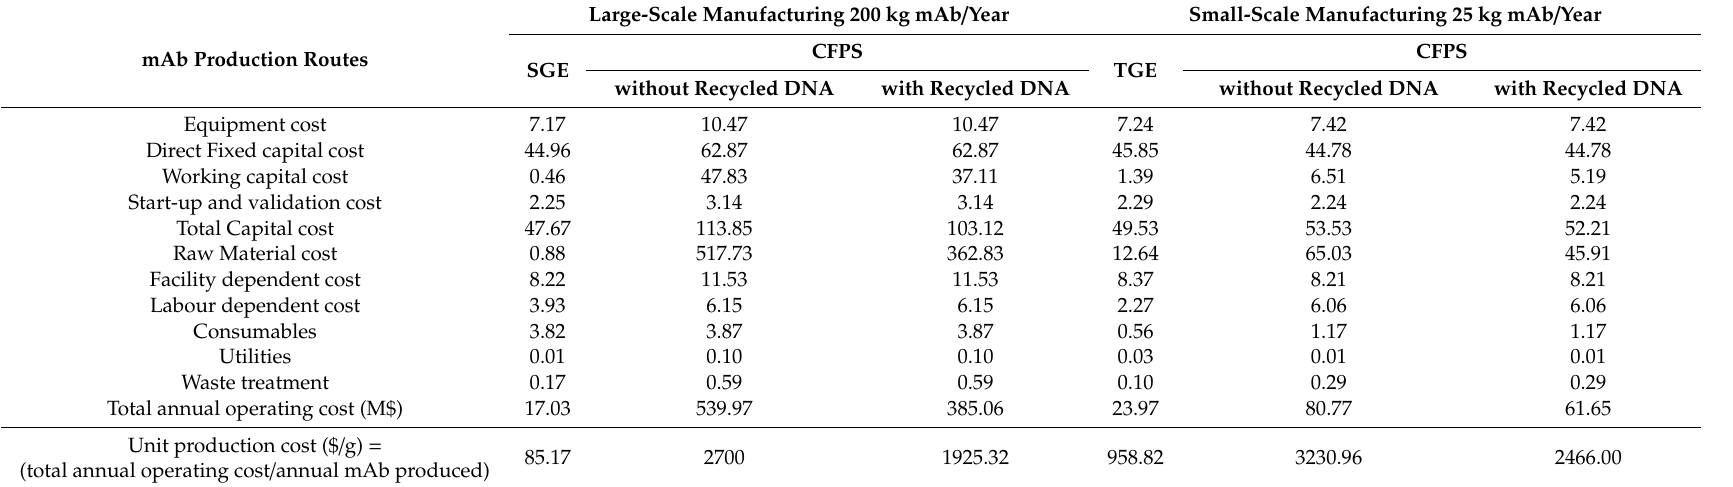
Table 1. Process economics for mAb production for large-scale (SGE, CFPS) and small-scale manufacturing (TGE,